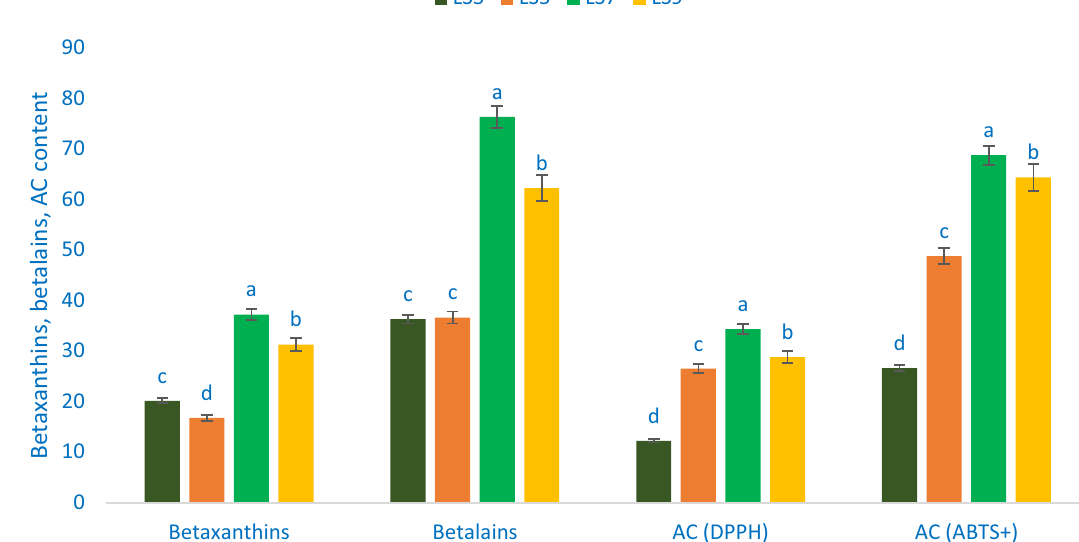
Figure 5. Betaxanthins, betalains, and antioxidant capacity in four selected A. gangeticus leafy vegetables, betaxanthins (mg 100 g −1 FW), betalains (mg 100 g −1 FW), AC (DPPH) = Antioxidant capacity (DPPH) (TEAC µg g −1 DW), AC (ABTS + ) = Antioxidant capacity (ABTS + ) (TEAC µg g −1 DW), different letters in the blue and green bars are differed significantly by Duncan Multiple Range Test ((P < 0.01), (n =